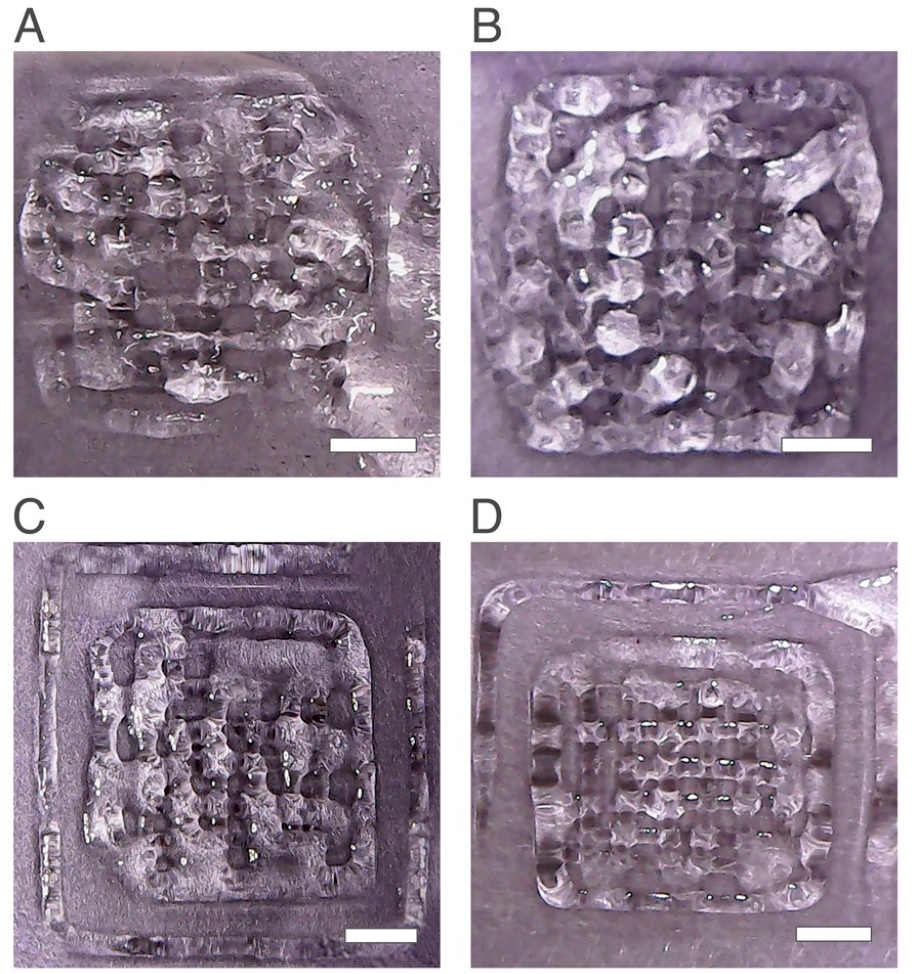
Figure 2. Printed scaffolds with 2.5 wt% chitosan obtained with the same printing conditions except layer height (LH) and flow speed (FS). ( A ) 0.25 mm LH and 0.5 mm/s FS, ( B ) 0.41 mm LH and 0.50 mm/s FS, ( C ) 0.41 mm LH and 0.25 mm/s FS and ( D ) 0.41 mm LH and 0.15 mm/s FS. The scale bars measure 5 mm.